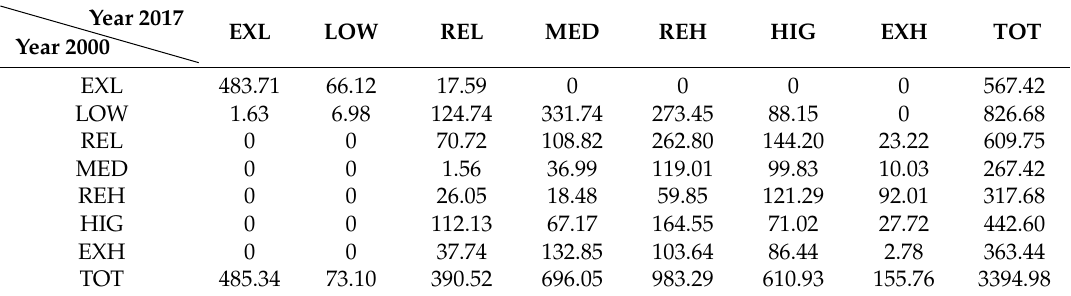
Transition matrix for changes in the area (km 2 ) of landscape types in the OCWJ during